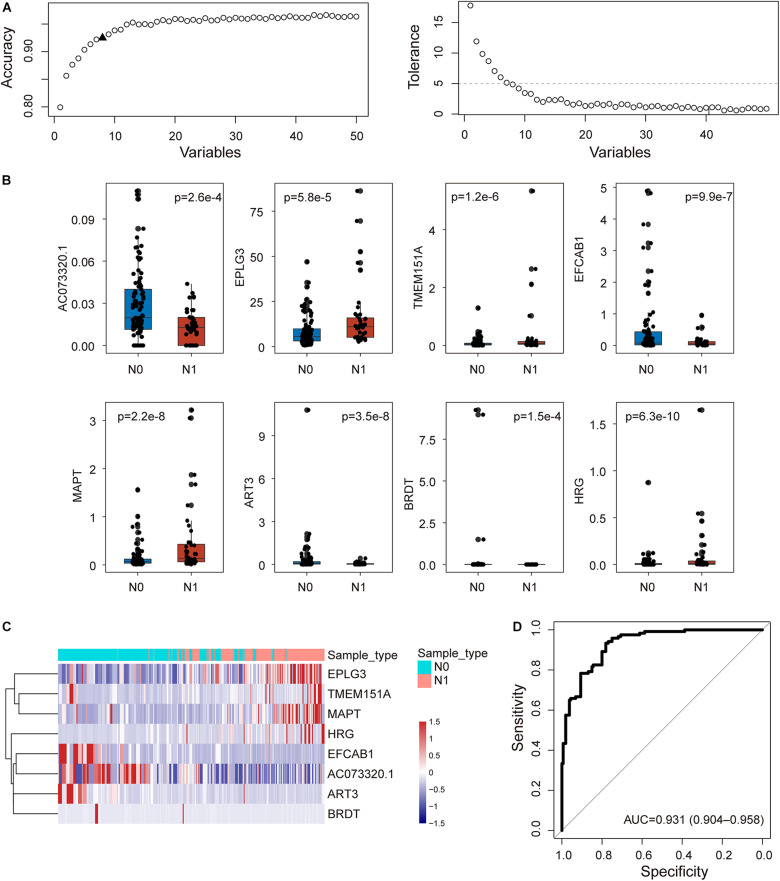
Development of the coding-non-coding RNA signature in the discovery cohort. (A) The predicted accuracy of each combination is constructed by a specific number of candidate biomarkers. (B) Boxplots displaying expression pattern of eight biomarkers. (C) Unsupervised clustering of patients based on the expression levels of eight biomarkers. (D) Receiver operating characteristic (ROC) curves for the coding-non-coding RNA signature in predicting lymph node metastasis.